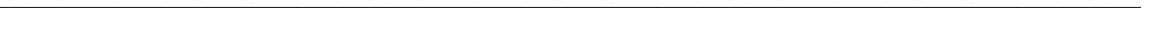
Fig. 3. Selected conodonts from the Late Ordovician of Normandy, France. A (cid:150) C , H (cid:150) K , Amorphognathus sp.: A, Pa element, upper view of IPUM 28749, Level C; B, C, Pb elements, lateral views of IPUM 28750 and IPUM 28751, Level C and Level 1 respectively; H, Sa element, lateral view of IPUM 28755, Level C; I, Sb element, lateral view of IPUM 28756, Level 1; J, Sc element, lateral view of IPUM 28757, Level C; K, Sd element, lateral view of IPUM 28758, Level 4. D , E , Amorphognathus ordovicicus Branson & Mehl, 1933: M element, posterior (D) and outer-lateral (E) views of IPUM 28752, Level 4. F , G , Amorphognathus duftonus Rhodes, 1955: F, M element, postero-lateral view of IPUM 28753, Level 6 top; G, M element, outer-lateral view of IPUM 28754, Level 4. L , Istorinus erectus Kn(cid:252)pfer, 1967: IPUM 28759, Level 1. M , N , Icriodella cf. superba Rhodes, 1953: M, Pa element, upper view of IPUM 28760, Level C; N, S element, lateral view of IPUM 28761, Level B. O (cid:150) R , Hamarodus brevirameus (Walliser, 1964): O, Pa element, lateral view of IPUM 28762, Level B; P, Pb element, lateral view of IPUM 28763, Level B; Q, M element, lateral view of IPUM 28764, Level C; R, Sc element, lateral view of IPUM 28765, Level 1. S (cid:150) U , Scabbardella altipes (Henningsmoen, 1948): S, lateral view of IPUM 28766, Level 2; T, lateral view of IPUM 28767, Level 2; U, lateral view of IPUM 28768, Level 1. V , Panderodus gracilis (Branson & Mehl, 1933), lateral view of IPUM 28769, Level B. W , Z (cid:150) AF , Sagittodontina robusta Kn(cid:252)pfer, 1967: W, P element, lateral view of IPUM 28770, Level B; Z(cid:150)AB, P element, lateral, upper and upper-lateral views of IPUM 28772, Level C; AC, M element, posterior view of IPUM 28773, Level 1; AD, Sa element, posterior view of IPUM 28774, Level 1; AE, Sb element, lateral view of IPUM 28775, Level 1; AF, Sd element, postero-lateral view of IPUM 28776, Level 6 top. X, Y , ? Baltoniodus sp., Pb element, upper and lateral views of IPUM 28771, Level 1. Scale bar represents 100 (cid:181)m for all